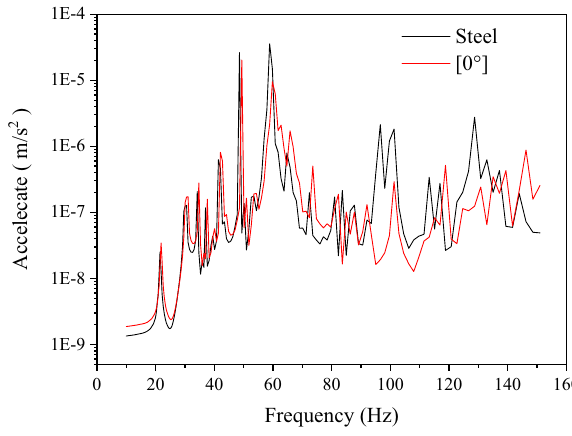
Figure 5: Comparison of mean square acceleration response of composite and steel fl oating rafts.